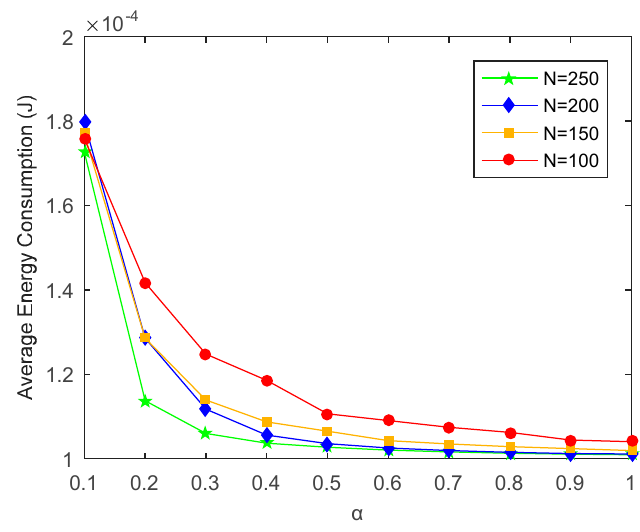
α Figure 4. Impact of on average energy consumption (P = 0.3 W). Figure 4. Impact of α on average energy consumption (P = 0.3 W).